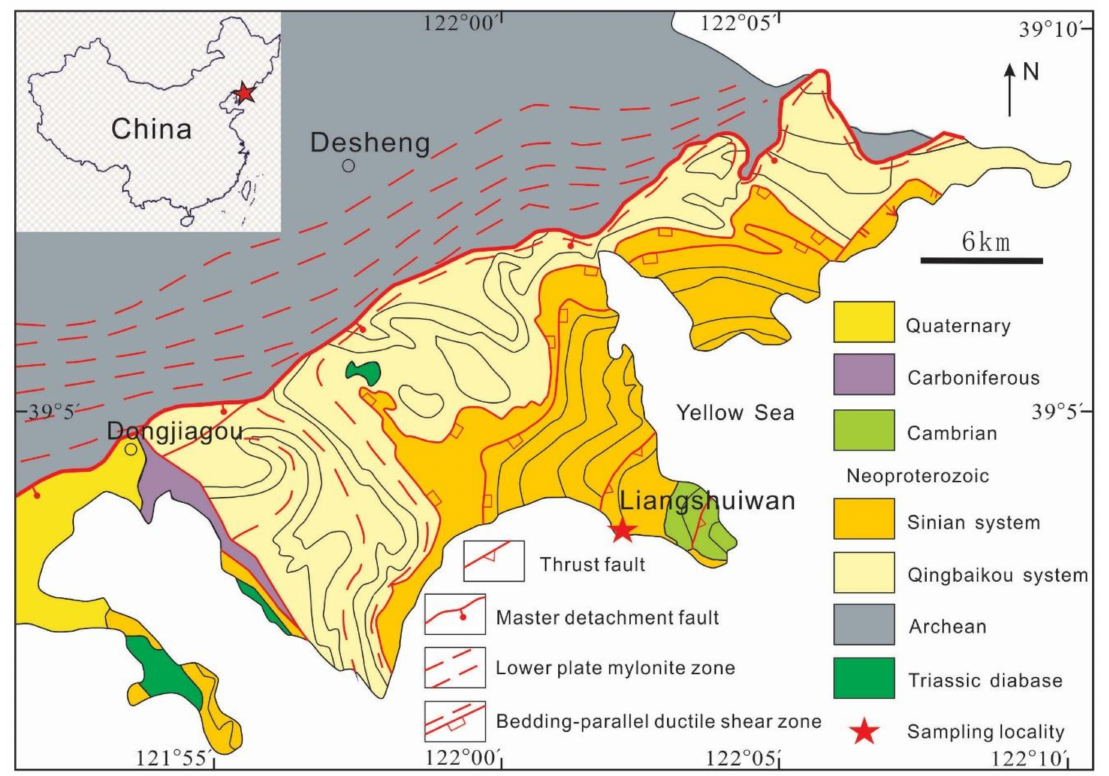
Figure 1. Location map of the field area and geology on the Liaonan Peninsula in Northeast